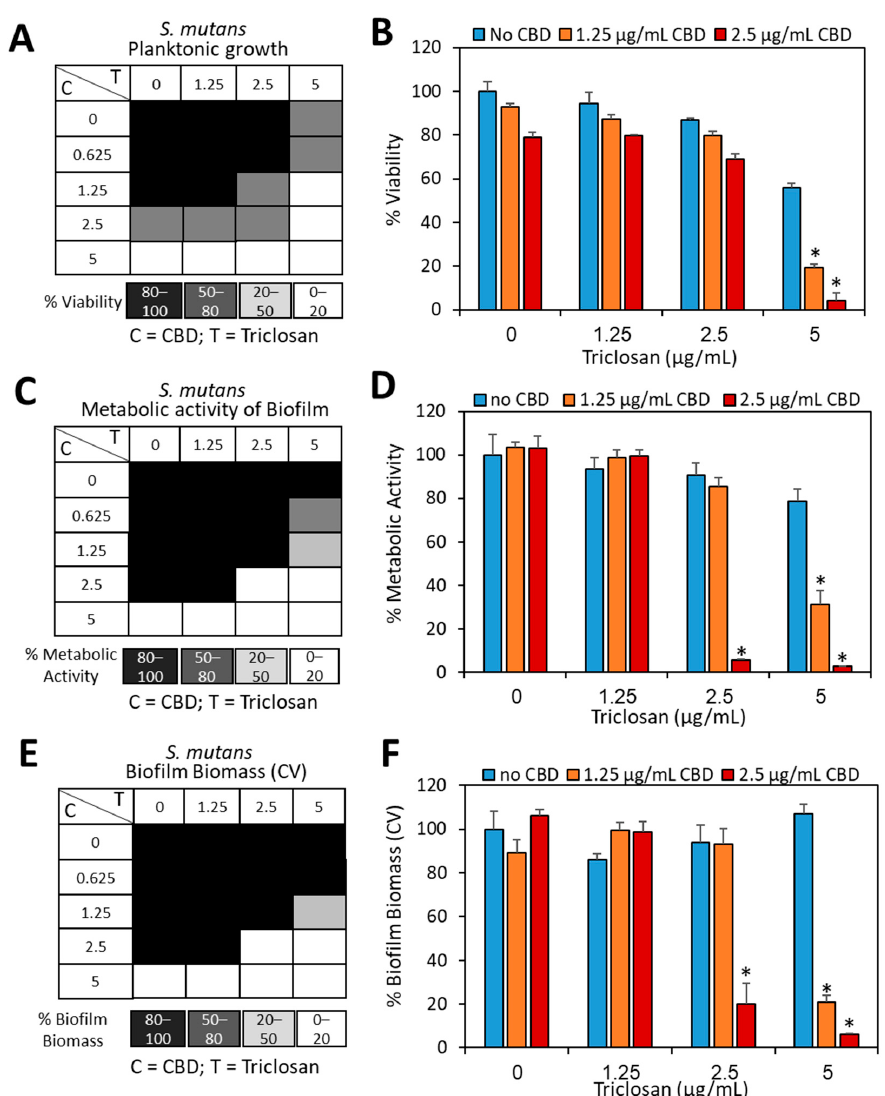
Figure 2. Increased anti-bacterial and anti-biofilm activity of combined triclosan/CBD treatment against S. mutans . ( A ). Checkerboard of triclosan and CBD on planktonic growth. ( B ). The % viability of S. mutans treated for 24 h with the indicated concentrations of triclosan and CBD. ( C , E ) Checkerboard of triclosan and CBD on biofilm formation as measured by MTT metabolic assay ( C ) or CV staining ( E ). ( D , F ) The % biofilm formation of S. mutans treated for 24 h with the indicated concentrations of triclosan and CBD as measured by MTT metabolic assay ( D ) or CV staining ( F ). * p < 0.05 in comparison to the treatment with each compound alone. N = 3.